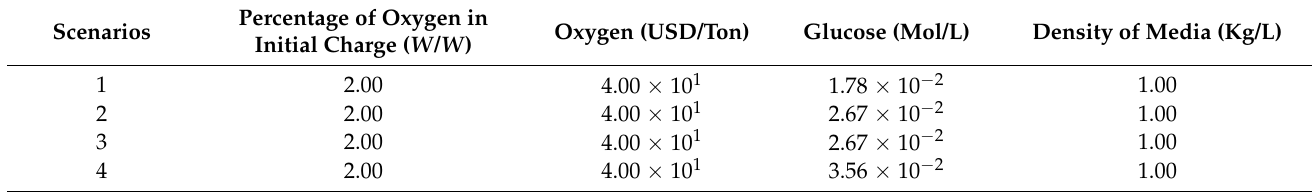
Table A4. Model variable inputs: Media continued